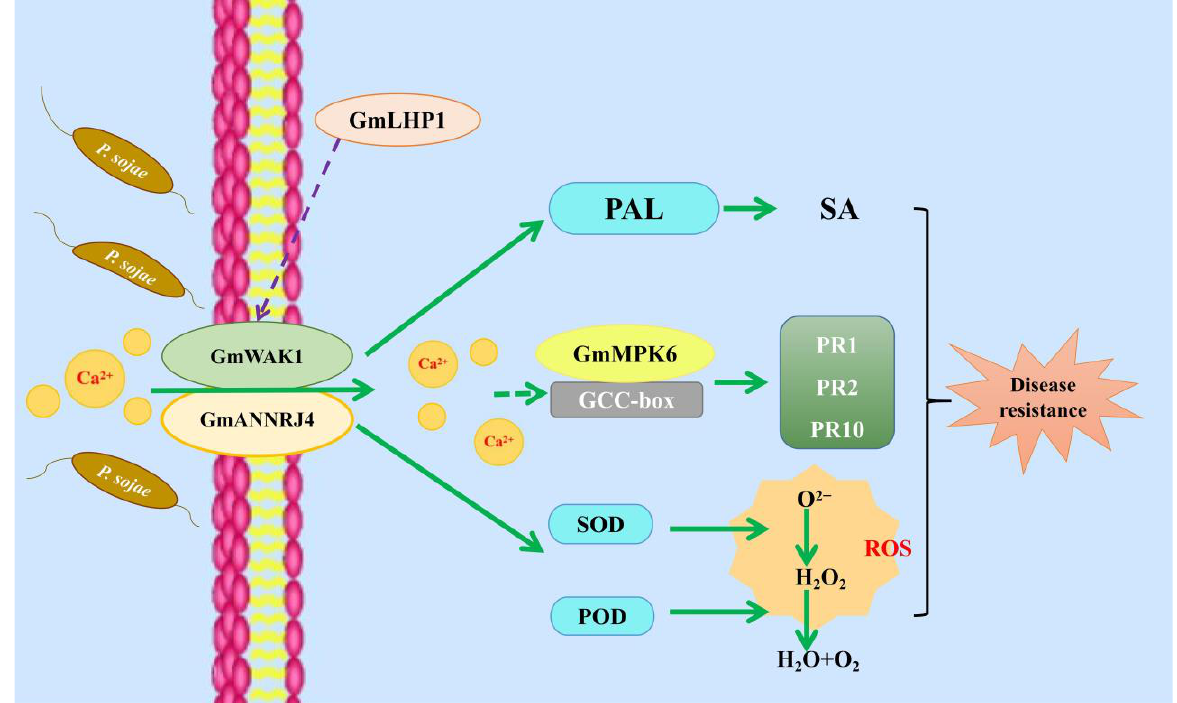
Figure 8. Working model illustrating how GmWAK1 and GmANNRJ4 activate defense-related genes during P. sojae infection.